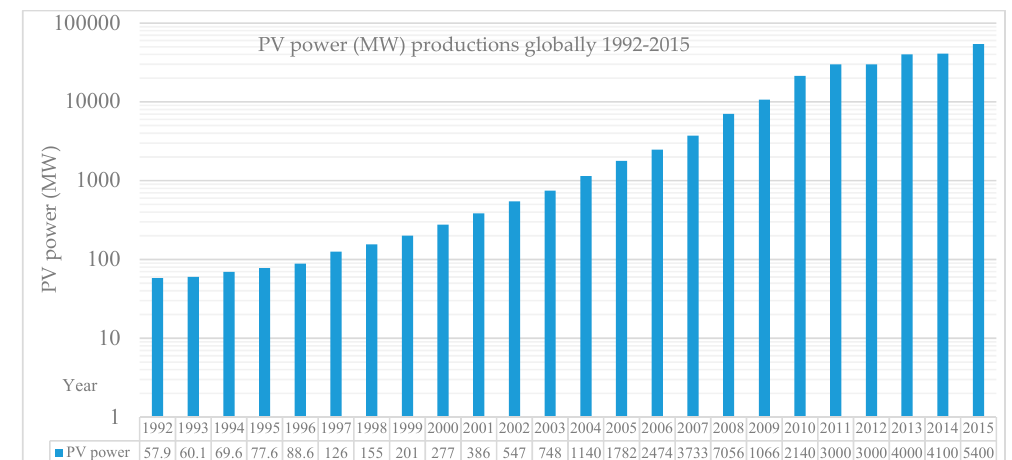
Figure 2. Total PV power (MW) productions globally 1992–2015.